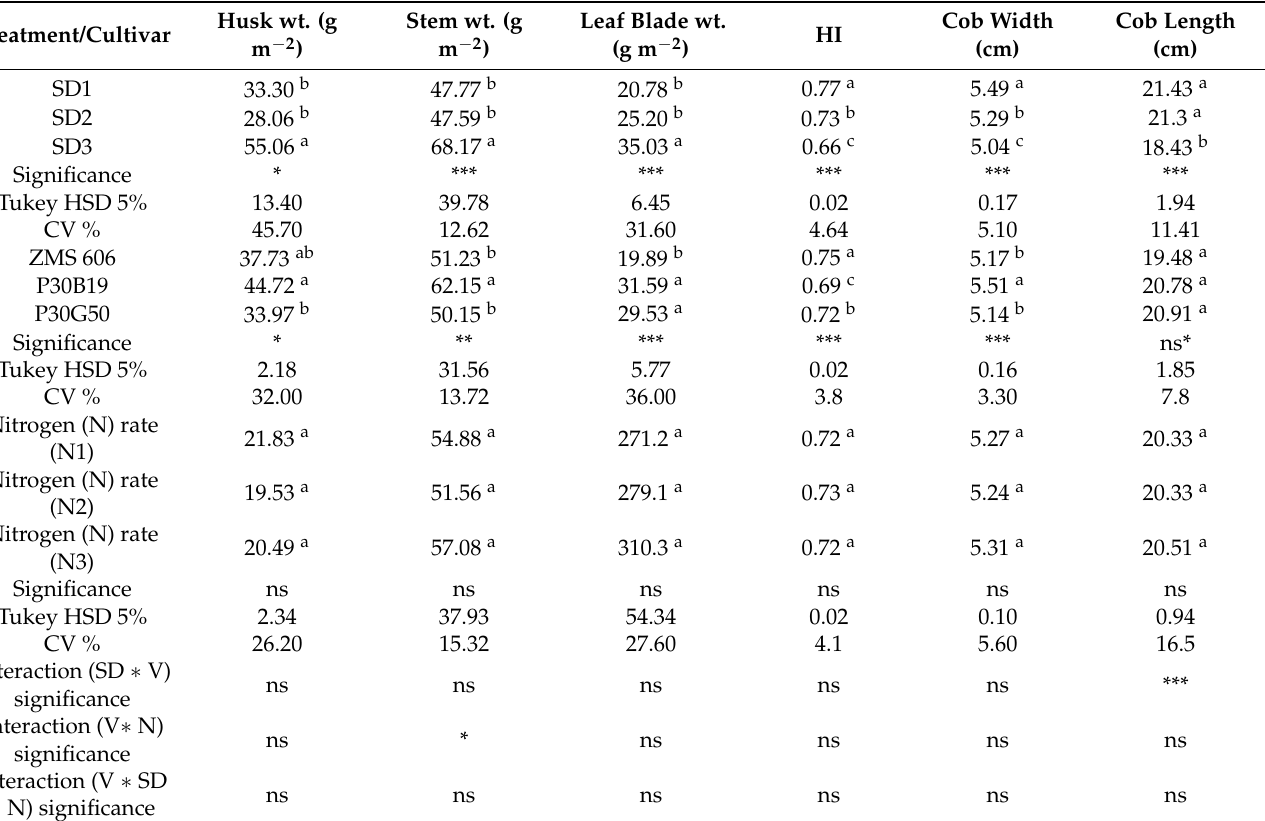
Table 4. Treatment effect of the sowing date, cultivar and N on the husk wt., stem wt., leaf blade wt., harvest index, cob width and cob length under rainfed